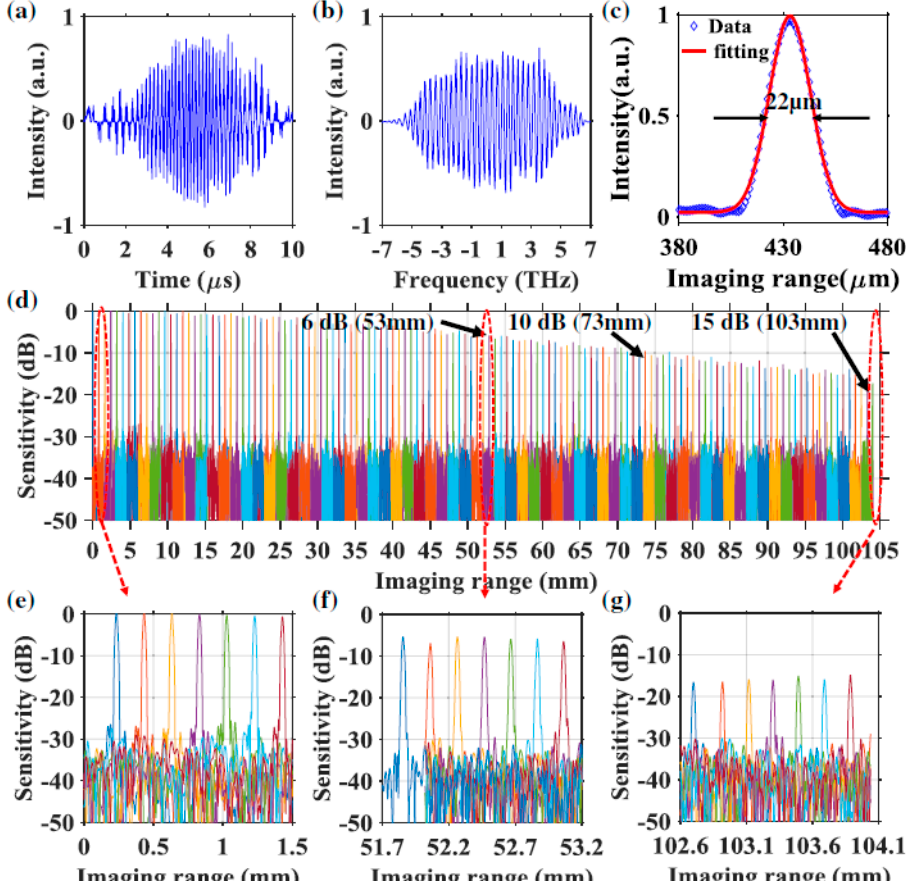
Figure 9. ( a ) Example of raw interference fringe pattern with microring comb filter captured by the BPD. ( b ) Resampled interference spectrum with self-clocking. ( c ) Axial resolution estimation with PSF calculated from the signal of ( b ). The measured PSFs of frequency comb swept laser with microring comb filter for OCT imaging range from ( d ) 0 to 104 mm, ( e ) 0 to 1.5 mm and ( f ) 51.7 to 53.2 mm, covering the 6 dB sensitivity roll-off length. ( g ) The zoom-in view from 102.6 to 104.1 mm, covering the 15 dB sensitivity roll-off length. Reprinted with permission from Ref. [80].